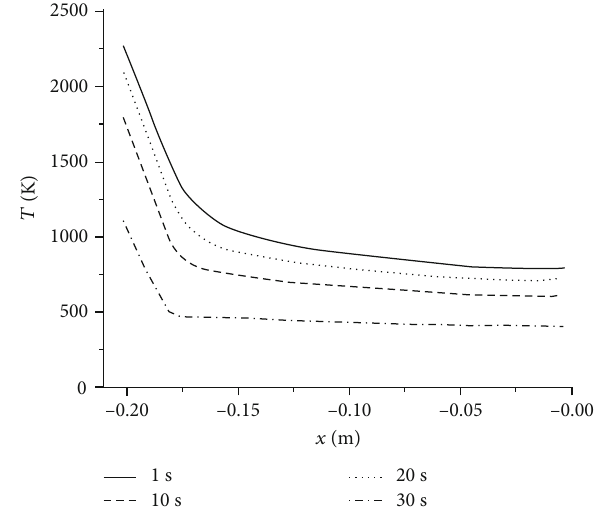
Figure 16: Temperature distribution along the